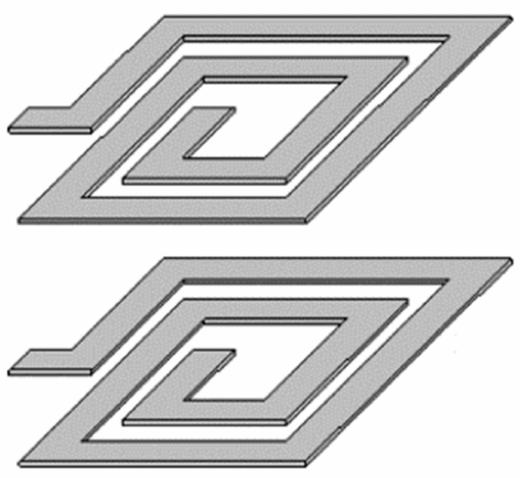
Figure 15. Vertical coupling of two spiral inductors